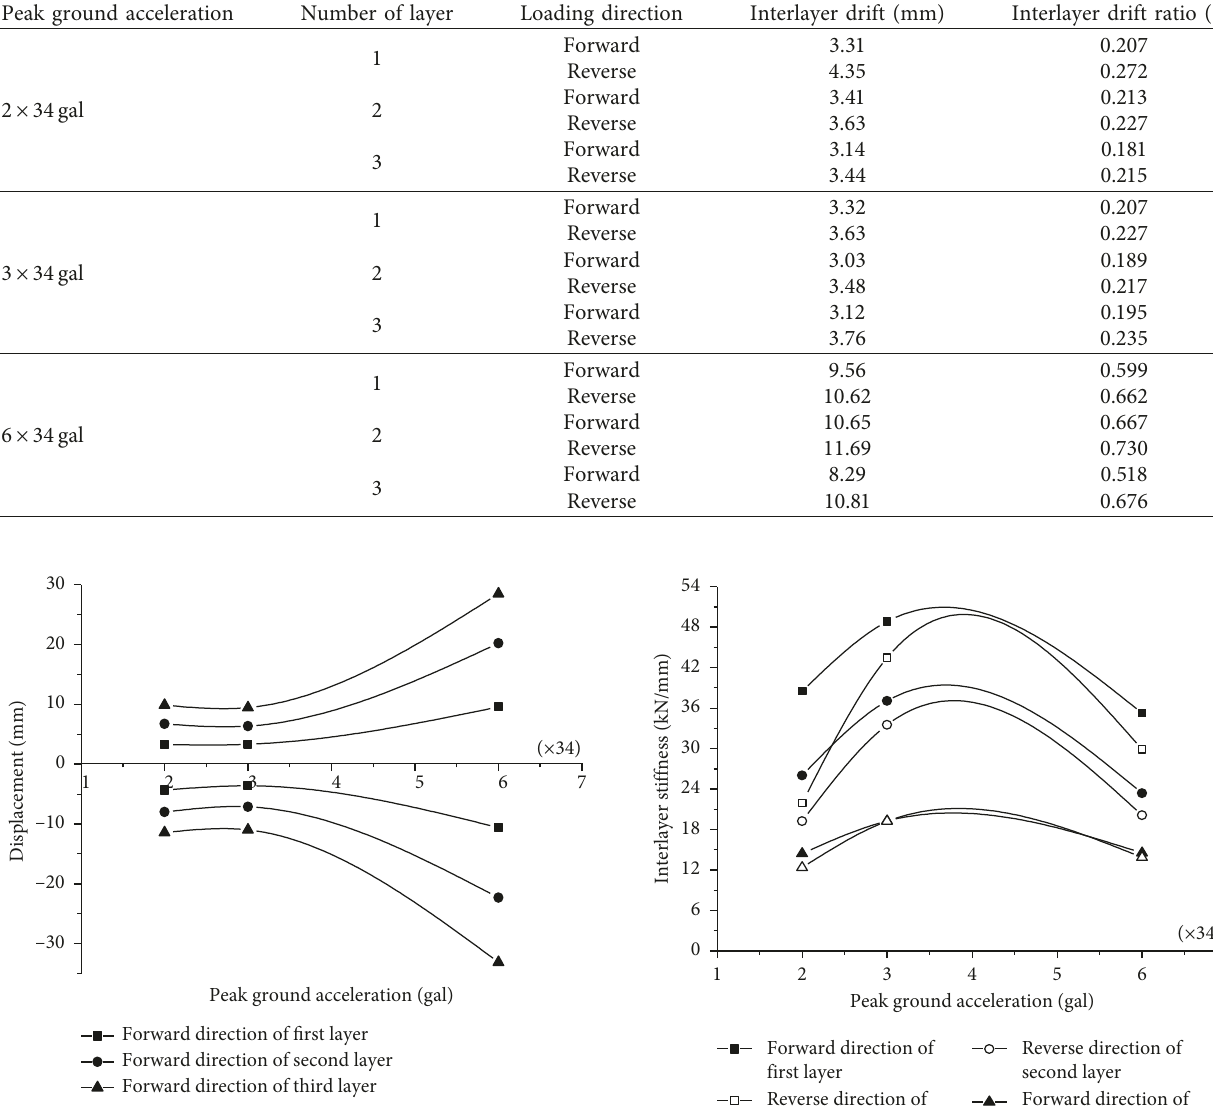
Figure 8: Peak ground accelerations-interlayer maximum dis- placement curves.